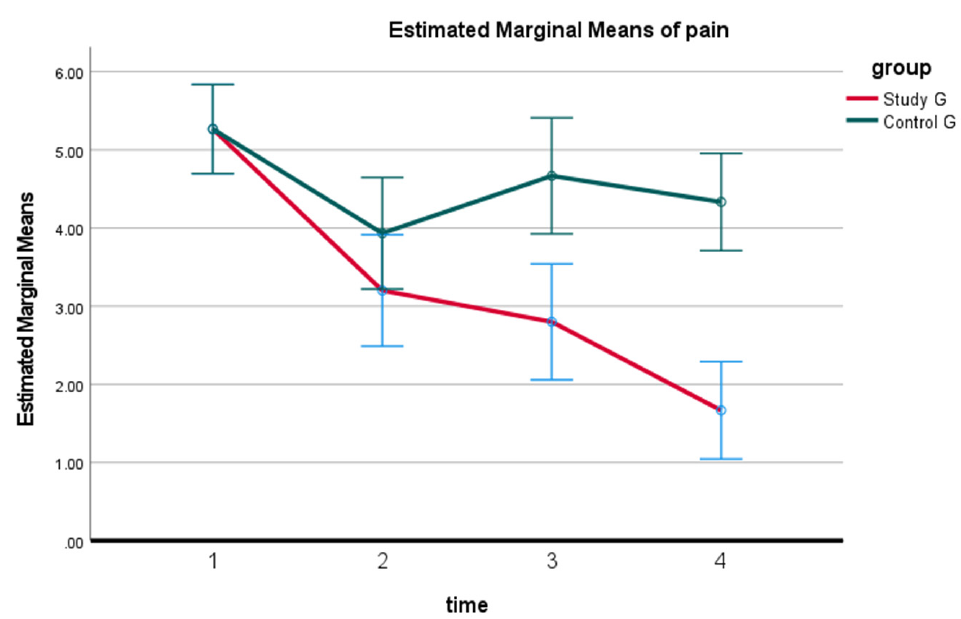
Figure 5. Differences in pain on the numerical rating scale (NRPS) during the study reported as mean ± SD for study and control groups at four time periods: baseline or pretreatment, after completion of the 10-week program, the 3-month follow-up, and the 2-year follow-up data. 1: pretreatment; 2: 10 weeks post-treatment; 3: at 3 months; 4: at 2-year follow-up.